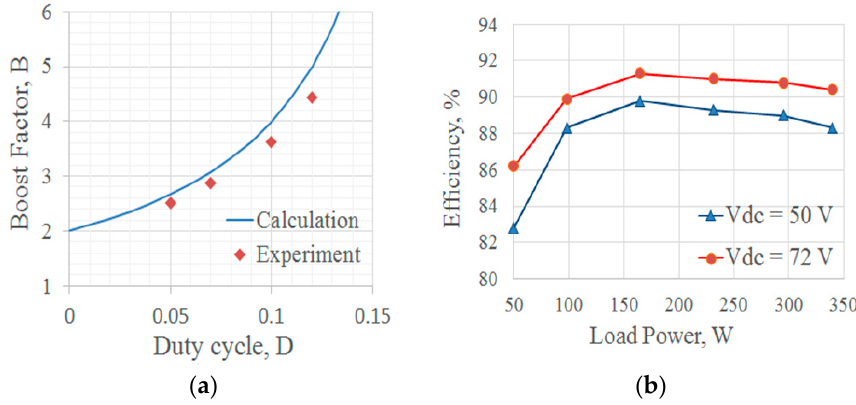
Figure 12. Measured results of ( a ) boost factor and ( b ) efficiency of the proposed inverter.